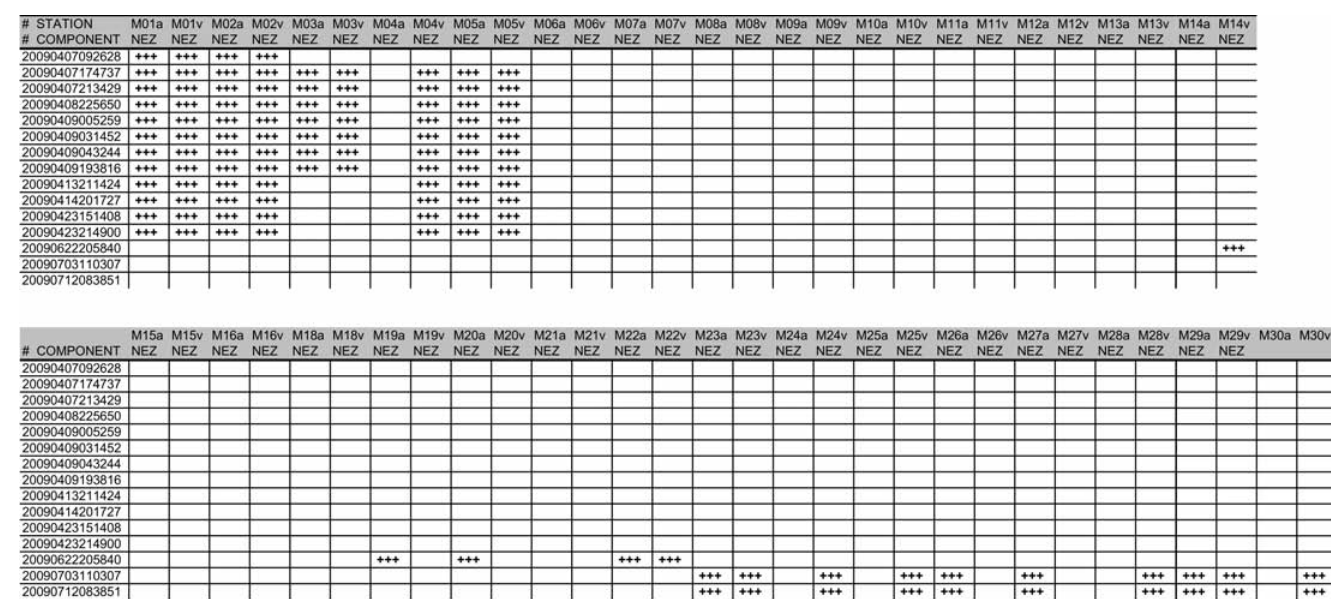
Table 5. Coincidence list of the dataset events for M ≥ 4.0. STATION: a = accelometer; v = velocimeter. COMPONENT: N = North-South; E = East-West; Z = Up-Down. For each event and for each station the existing components are marked as